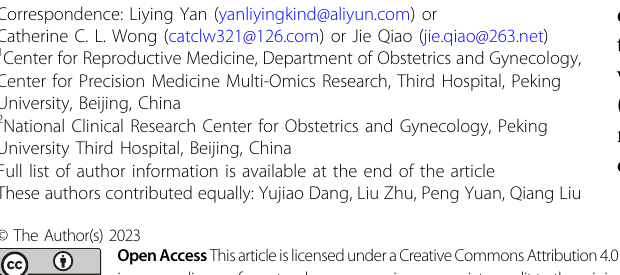
(Fig. 1a; Supplementary Table S1). Based on proteomic pro fi le, we identi fi ed approximately three thousand pro- teins in a single oocyte (Fig. 1b). Along embryonic size, the number of encoded proteins was reduced to approximately one thousand (1141) in single cells from blastocysts. The average correlation coef fi cient was ~0.7 among duplicates at each stage, indicating good repro- ducibility (Supplementary Fig. S1a, b). Principal compo- nent analysis (PCA) (Fig. 1c) and unsupervised hierarchical clustering (Supplementary Fig. S1c) showed that samples fi tted well to the corresponding stages of human embryo development, with the exception of three cells from morula-stage embryos which clustered with neighboring 8-cell blastomeres, indicating relatively high similarity of proteomic pro fi les between 8-cell embryos and